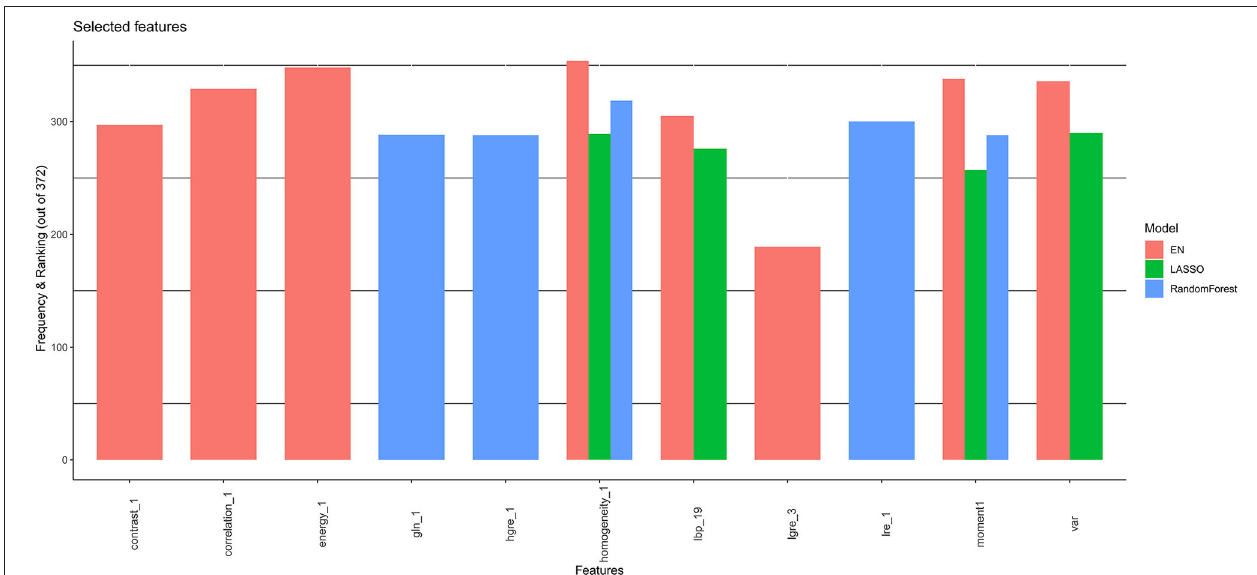
FIGURE 3 | Final selected features by CoxNet and Random Forest models. EN, elastic net; LASSO, Least Absolute Shrinkage and Selection